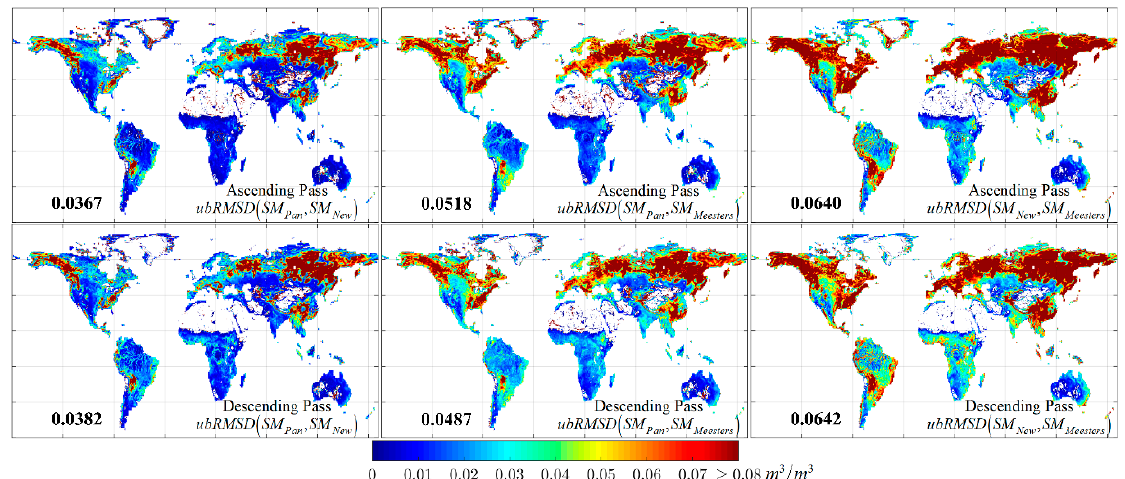
Figure 3. Unbiased root mean squared difference (ubRMSD) between the SM products obtained using the three solutions Γ C , New (indicated as SM New ), Γ C , Pan (indicated as SM Pan ) and Γ C , Meesters (indicated as SM Meesters ) for ascending and descending passes. The number in bold in each tile indicate the global average of ubRMSD computed between corresponding SM products.